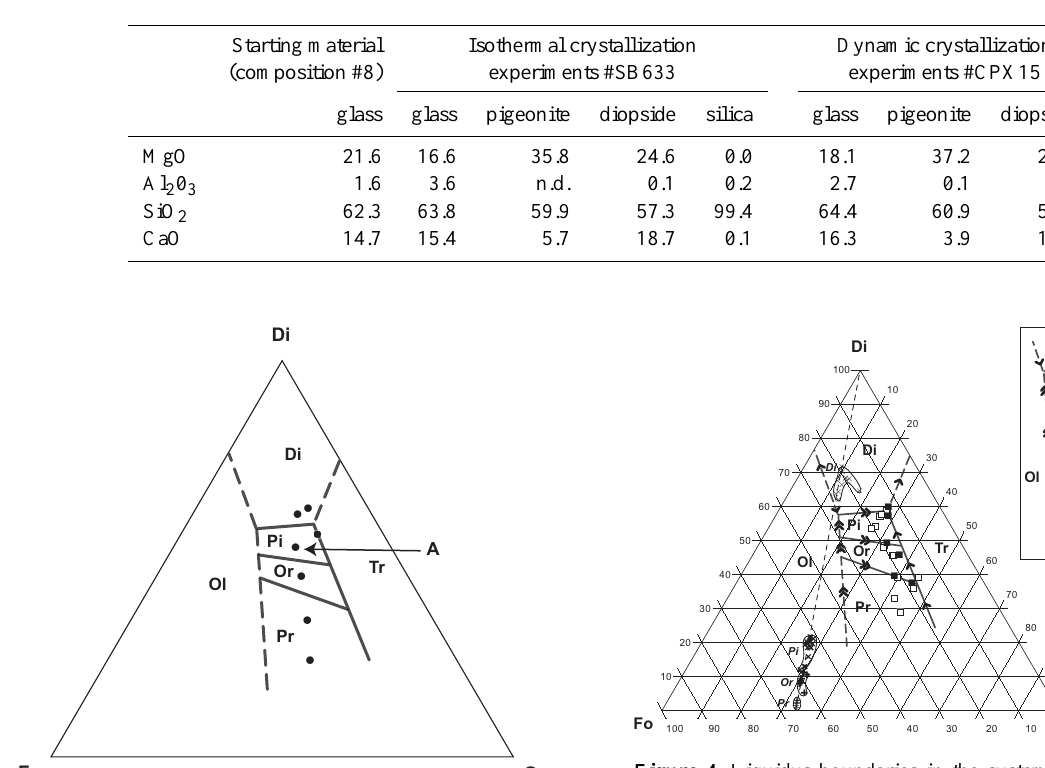
Table 3. Liquid and mineral compositions.